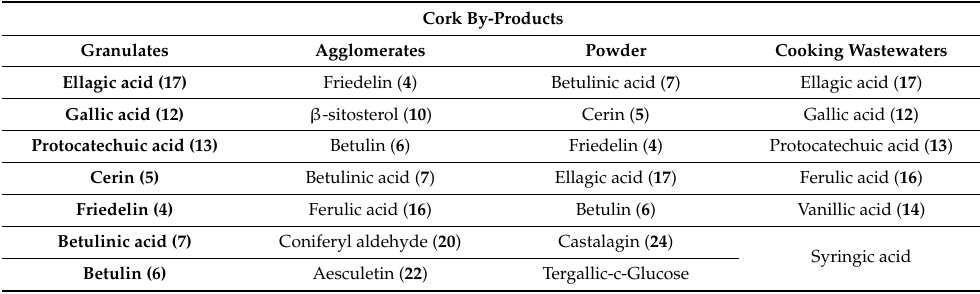
Figure 6. Chemical structures of recently identified tannins in cork by-products (cork powder and granulates). Table 1. Common compounds found in different cork by-products, based on the yields obtained from extractions described in